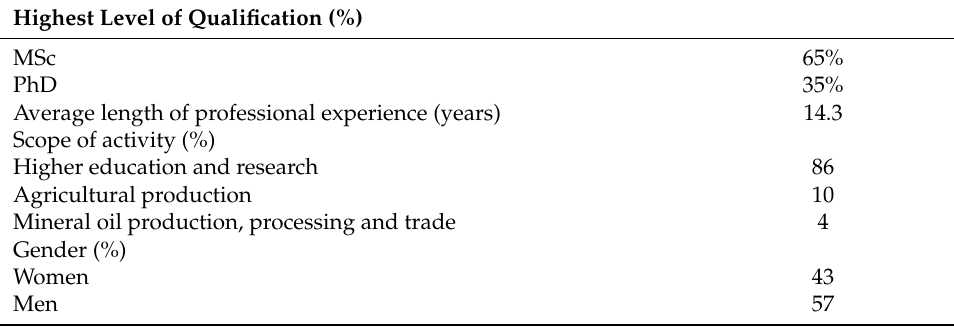
Table 6. Basic socio-economic characteristics of the